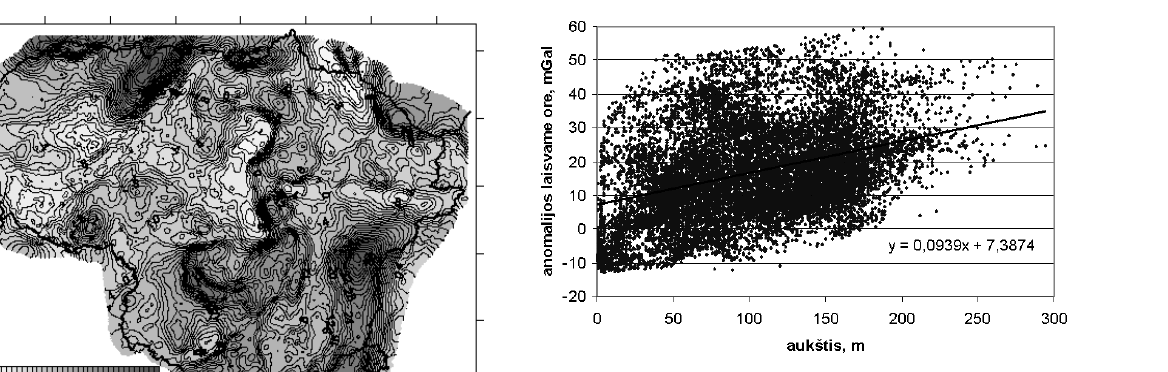
Fig 8. Correlation between topography and free–air anomalies Rytuose tarpinio sluoksnio tankiai yra mažiausi.